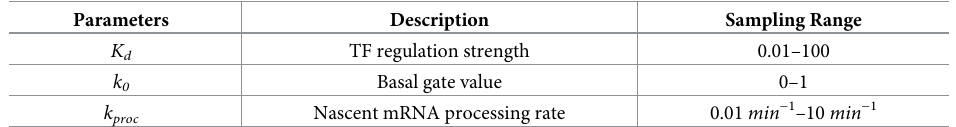
Table 2. Parameter